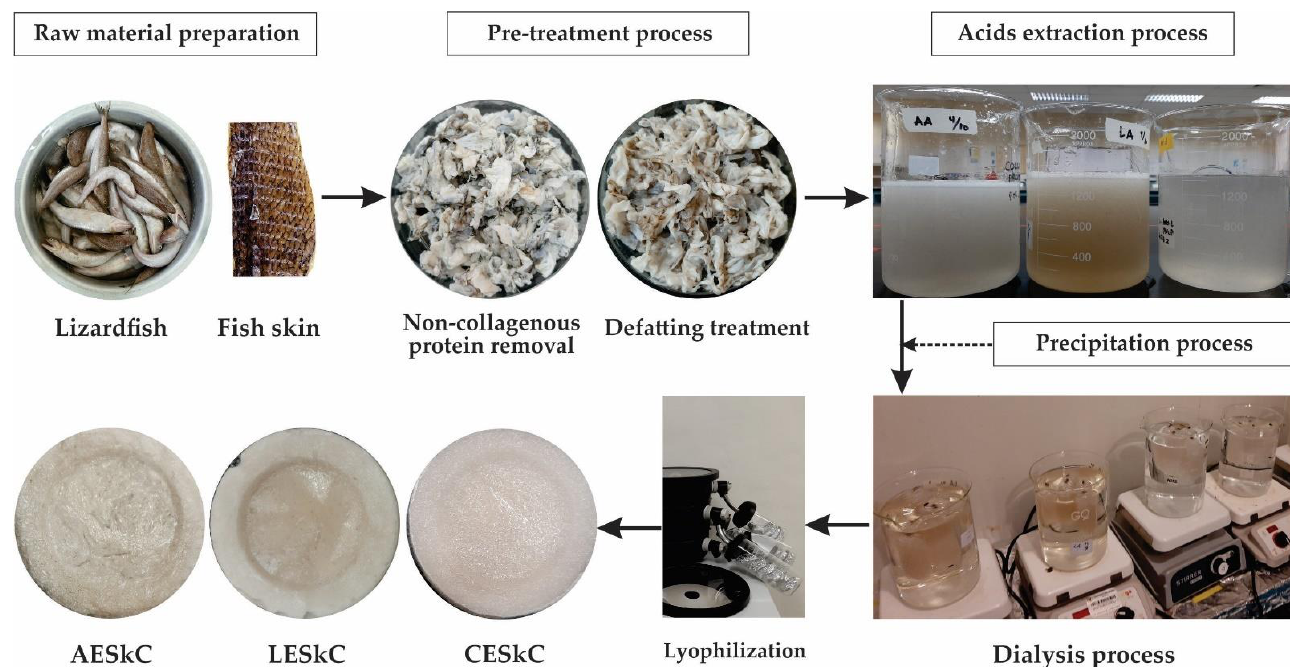
Figure 8. Extraction process of collagens from the skin of lizardfish. AESkC: acetic acid-extracted collagen; LESkC: lactic acid-extracted collagen; CESkC: citric acid-extracted collagen.